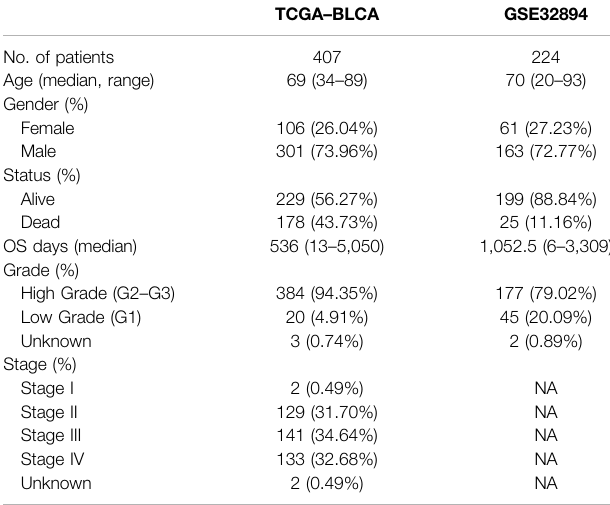
TABLE 1 | Clinical Characteristics of selected patients with